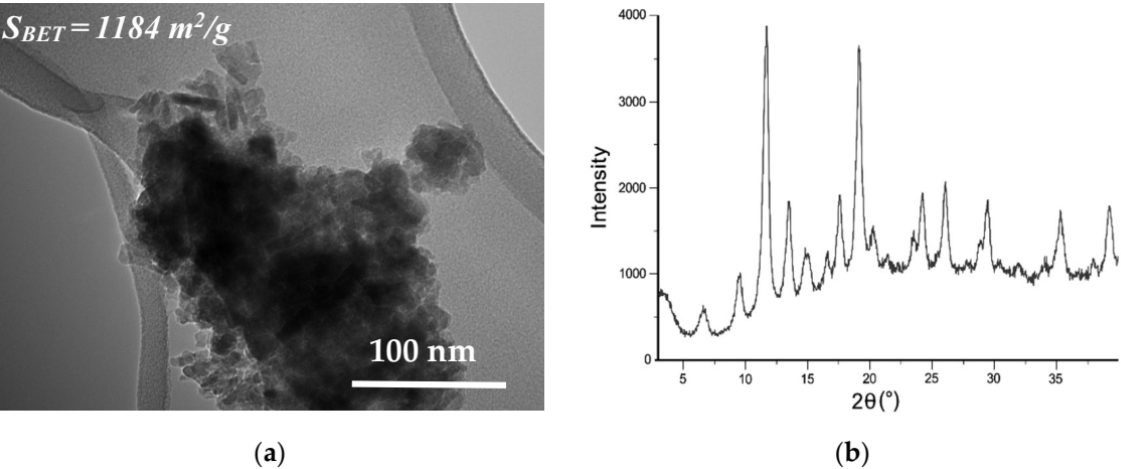
Figure 1. TEM micrograph ( a ) and PXRD pattern ( b ) of the HKUST-1 NPs synthesized under ionothermal conditions in the MW fields.